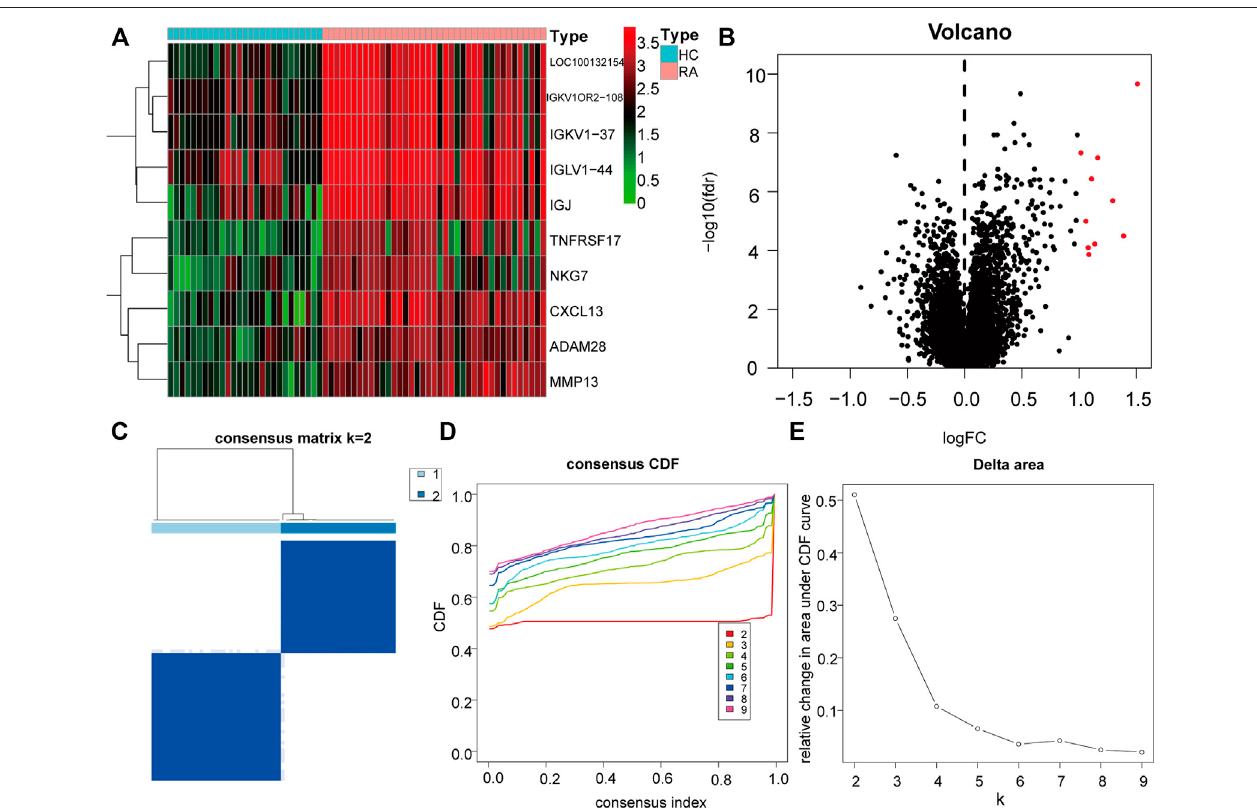
FIGURE 12 | Differential Genes and Molecular Types of Rheumatoid Arthritis. (A) : The heat map depicts the differential genes between RA and normal synovial tissues, the top ten highly expressed genes in RA were selected, (B) : The volcano map depicts the differences in gene expression between RA and normal synovial tissues, and the top ten highly expressed genes in RA tissues in the category were chosen. (C – E) : Clustering and grouping of synovial samples based on differential genesforrheumatoidarthritis. (D) :PCAanalysisunderdifferentgroups,whereredisclusterAandblueisclusterB. (E) :Differencesintheexpressionofkeygenesin different